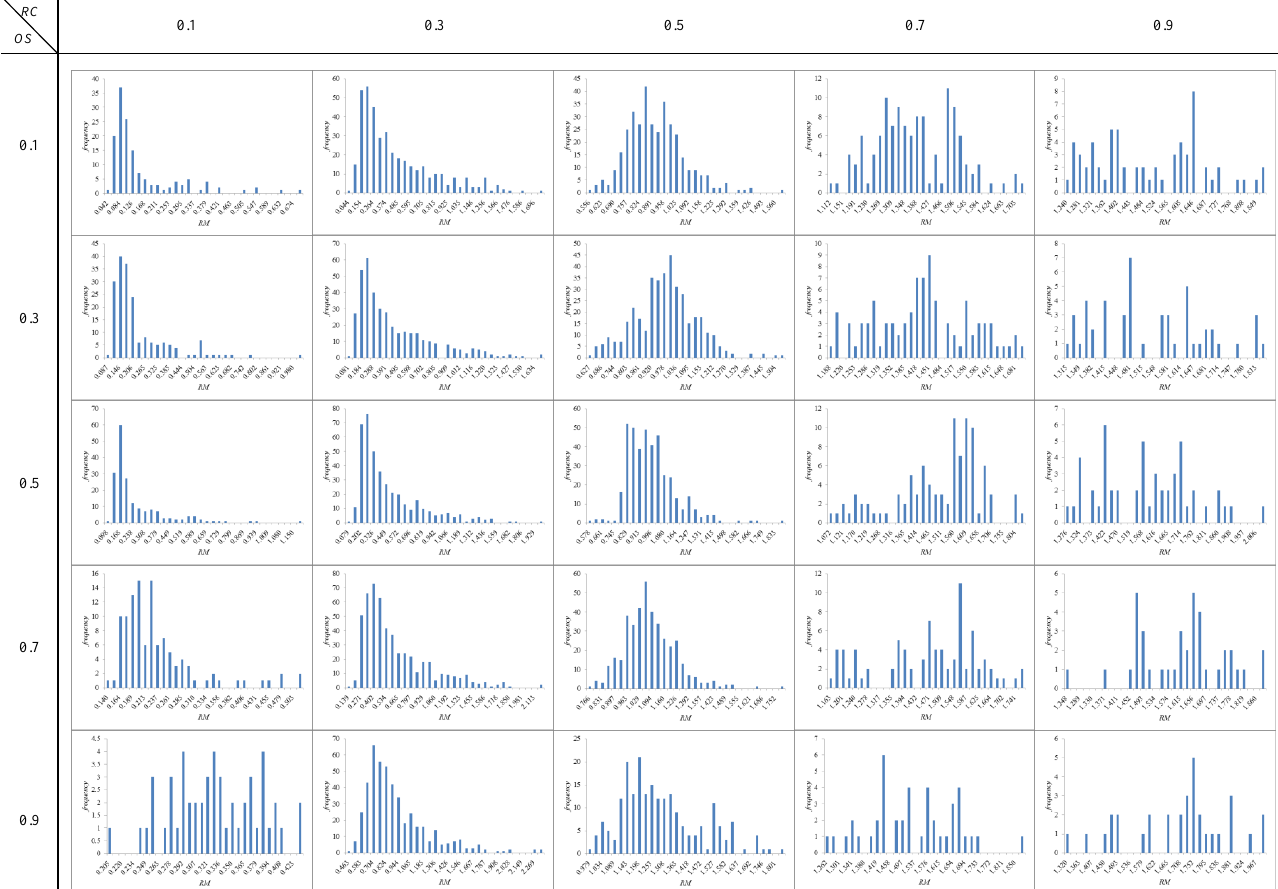
Fig.20 Distribution of RM under different settings of RC and